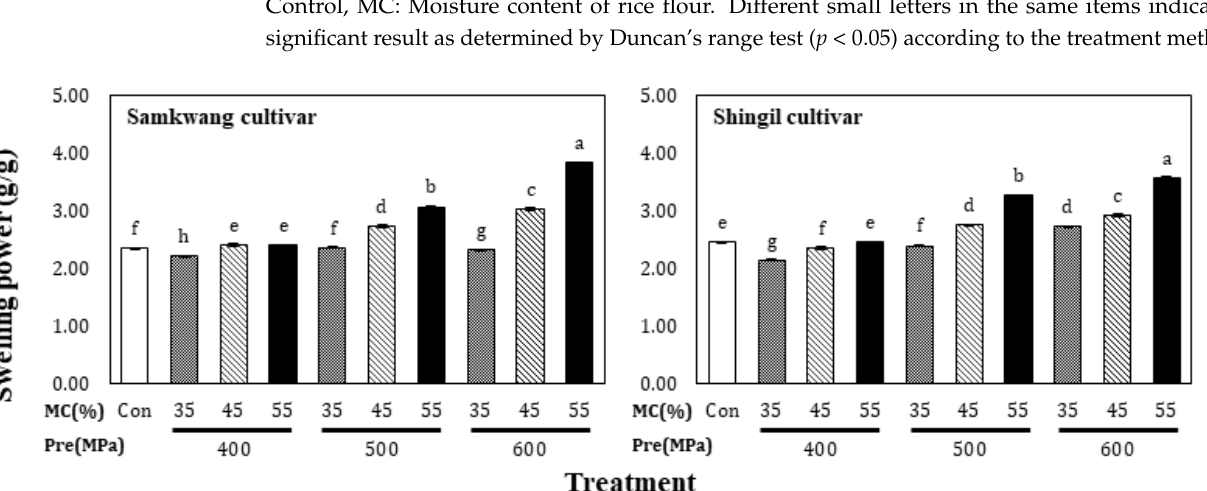
Figure 2. Solubility of high hydrostatic pressure-treated rice flour at different moisture levels. Con: Control, MC: Moisture content of rice flour. Different small letters in the same items indicate a significant result as determined by Duncan’s range test ( p < 0.05) according to the treatment method.